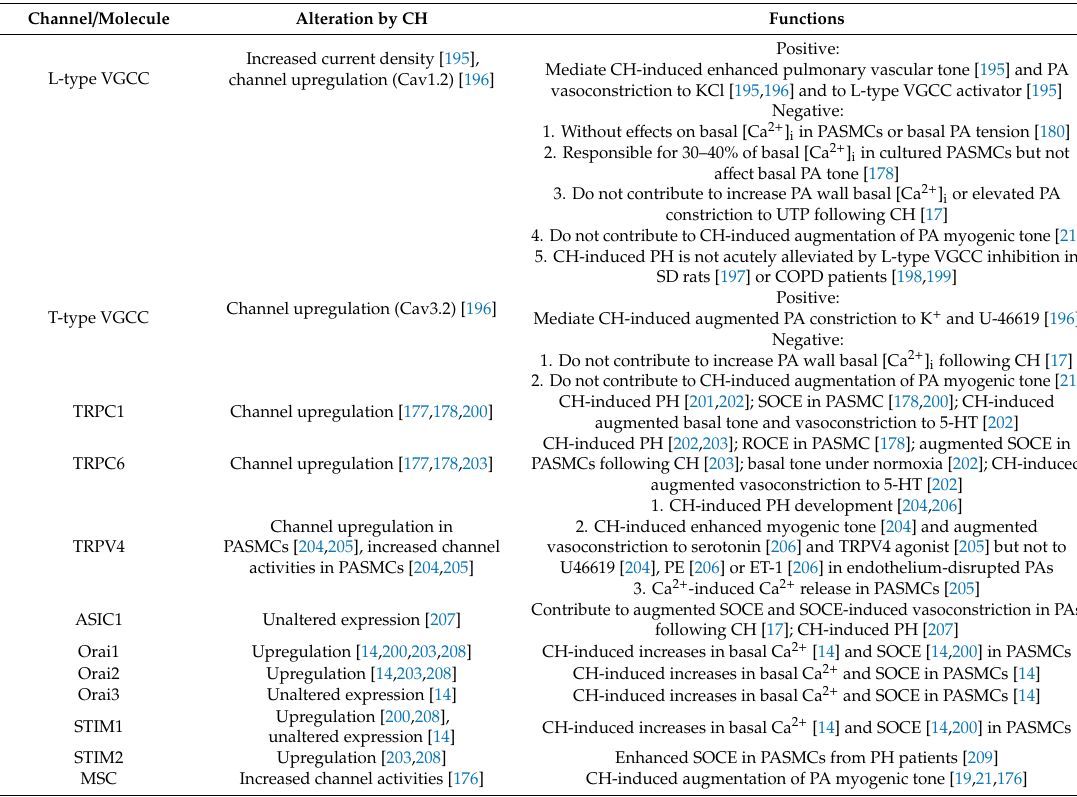
Table 2. Ca 2 + influx in CH-induced